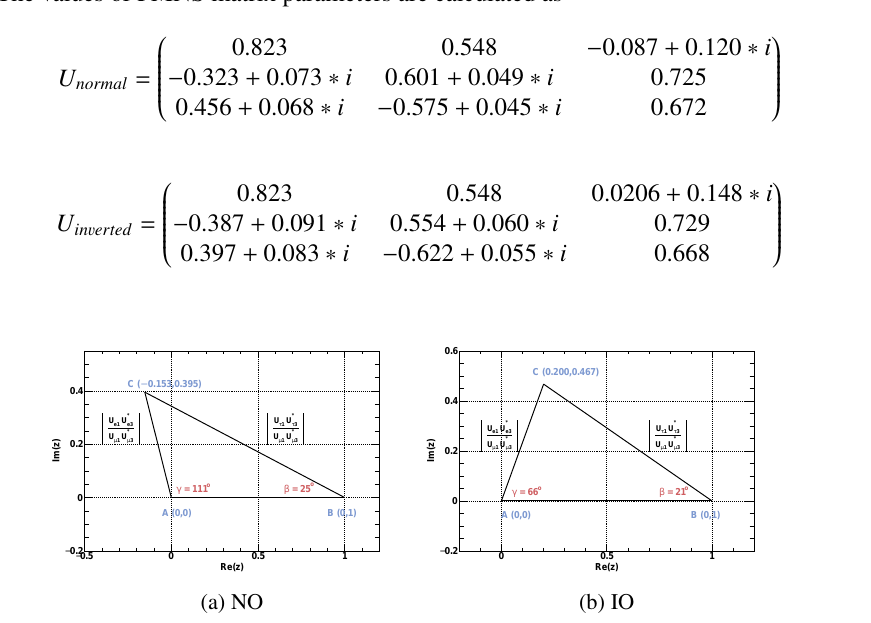
Figure 4.1: The unitary triangle for normal hierarchy and for inverted hierarchy corresponds to the unitary conditions on the first and third columns